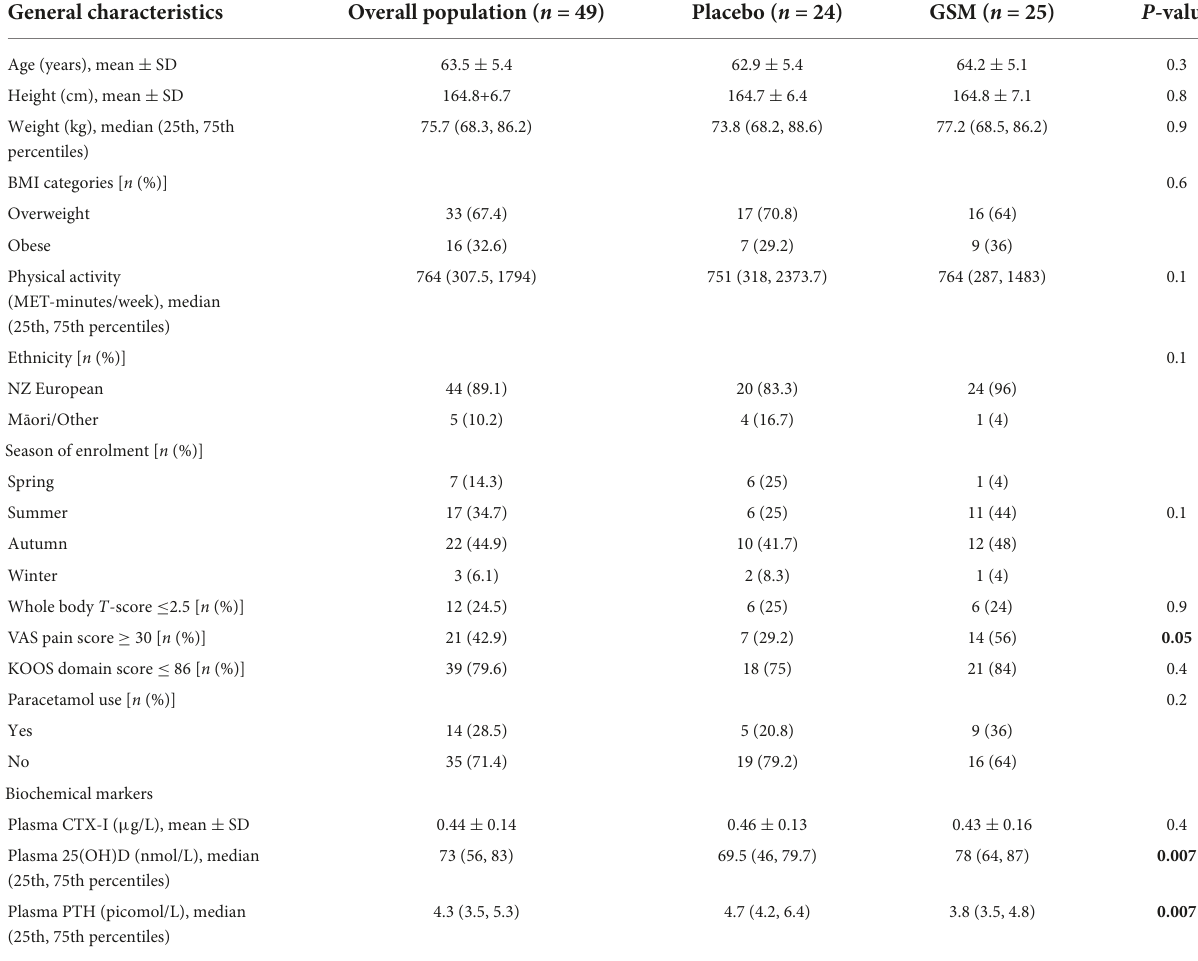
TABLE 1 General characteristics of participants who completed the